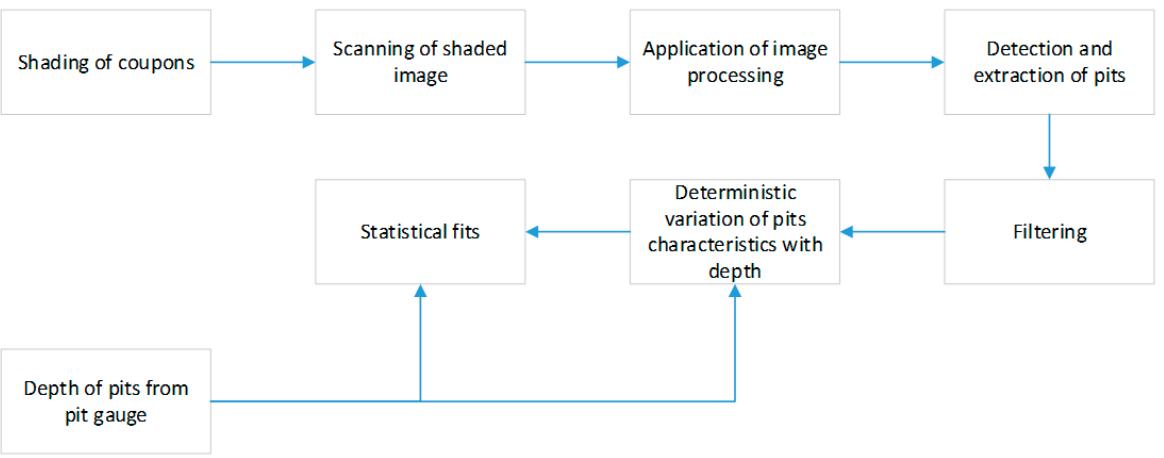
Figure 1. Flowchart of analysis for pits detection and sizing.